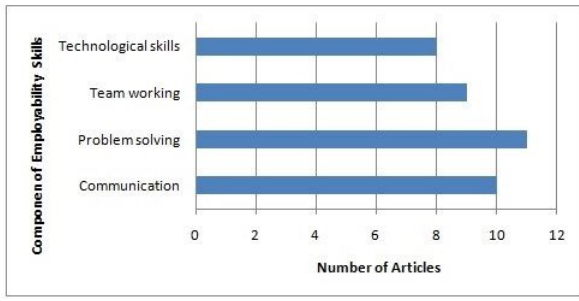
Figure 3: The Types of Employability Skills Needed by Employer